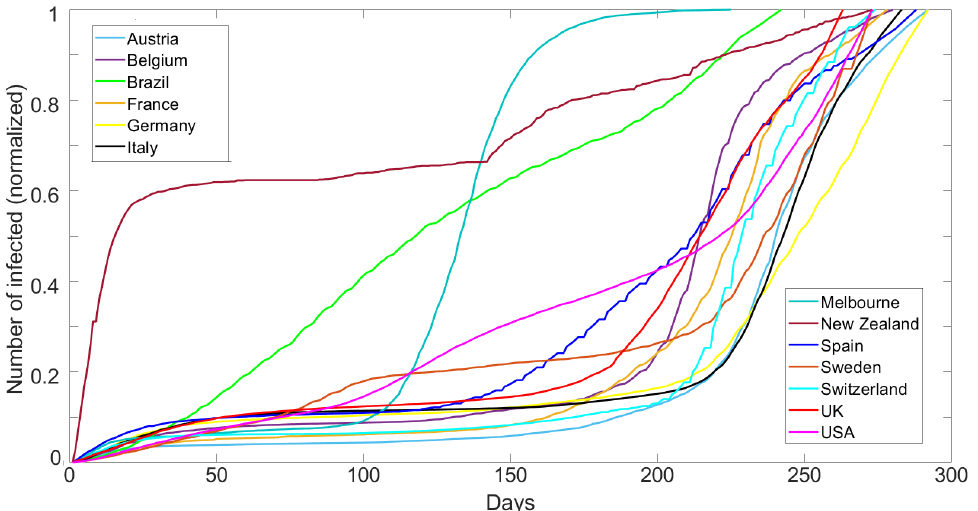
Figure 1. Compilation of reported cumulative infections for all cases studied and identified in the legend. The time range was 15 March 2020 to 4 January 2021 for all countries (Source: ECDC and Australian